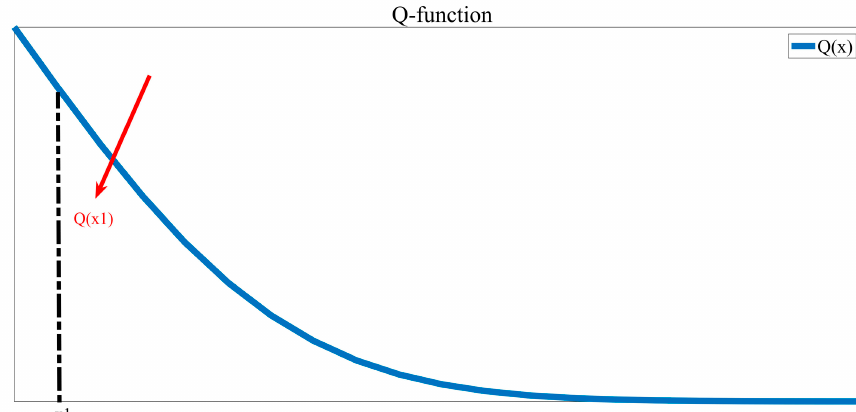
Figure A1. Q function graph.